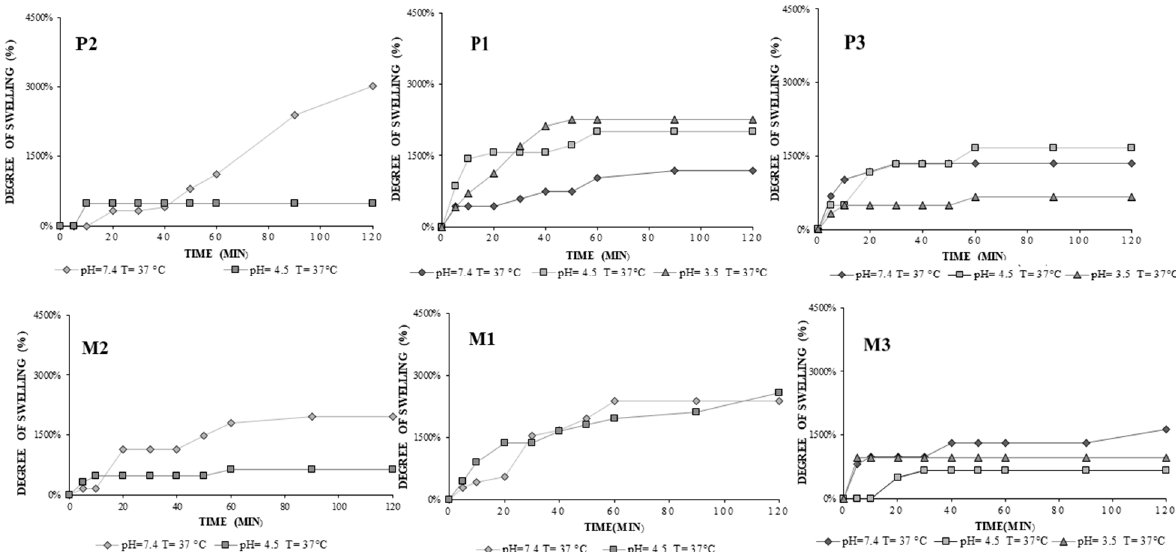
Figure 6. The influence of pH of the media on the swelling degree, at 37 °C. P1: CS-g-PNIPAAm/PVA 80/20 +PGT; M1: CS-g-PNIPAAm/PVA 80/20 ; P2: CS-g-PNIPAAm/PVA 95/5 +PGT; M2: CS-g- PNIPAAm/PVA 95/5 ; P3: CS-g-PNIPAAm/PVA 75/25 +PGT; M3: CS-g-PNIPAAm/PVA 75/25. The studied hydrogels showed significant Q variations depending on the pH